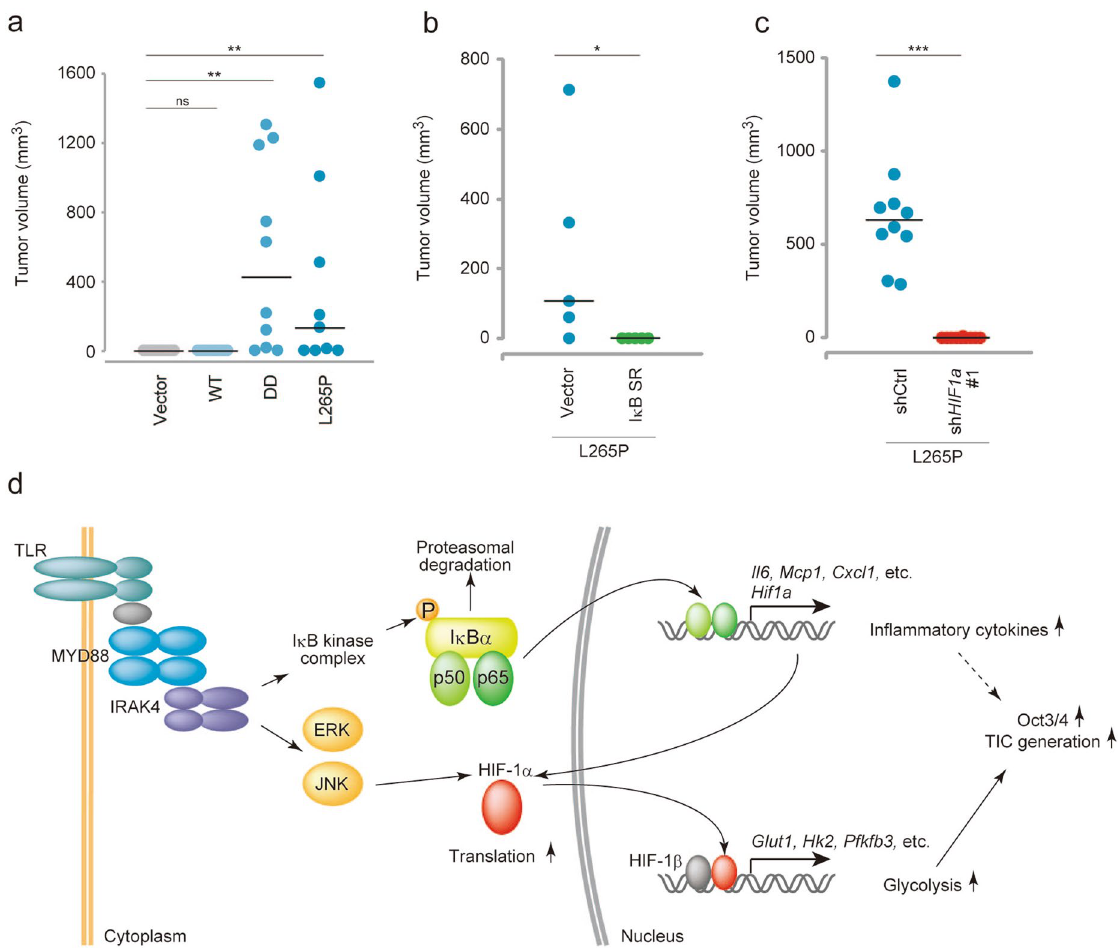
Figure 8. MYD88 L265P expressing p53 −/− MEFs form tumours via the NF-κB-HIF-1α axis. ( a – c ) Tumourigenesis experiments in vivo. Tumour sizes were monitored weekly. ( a ) The indicated gene-expressing p53 −/− MEFs (2.5 × 10 6 cells) were subcutaneously injected into 7-week-old nude mice (n = 10 per group, except L265P, n = 9). One mouse in the L265P group formed a tumour and was eliminated from this statistical analysis because of unknown death. ( b ) Vector or IκBSR introduced MYD88 L265P-expressing p53 −/− MEFs (1.6 × 10 6 cells) were subcutaneously injected into 7-week-old nude mice (n = 6 per group). ( c ) shCtrl or sh Hif1a introduced MYD88 L265P-expressing p53 −/− MEFs (2.5 × 10 6 cells) were subcutaneously injected into 7-week-old nude mice (n = 10 per group). ( d ) A graphical depiction of the mechanism of MYD88-induced TIC generation from p53 −/− MEFs. ( a – c ) For the statistical analysis, the Kruskal–Wallis test followed by the Steel–Dwass test as a post-hoc test were used for ( a ) and the Mann–Whitney U -test was used for ( b , c ) *P < 0.05, **P < 0.01, ***P < cells 48 . Although several mechanisms might be involved in TIC regulation by NF-κB, the current results indicate that NF-κB-induced HIF-1α activation is essential for TIC generation in MYD88 signal-activated p53 −/− MEFs. HIF-1 regulates the expression of genes that contribute to angiogenesis, metabolic reprogramming, extracel- lular matrix remodelling, EMT, motility, invasion, metastasis, cancer stem cell maintenance, immune evasion, and